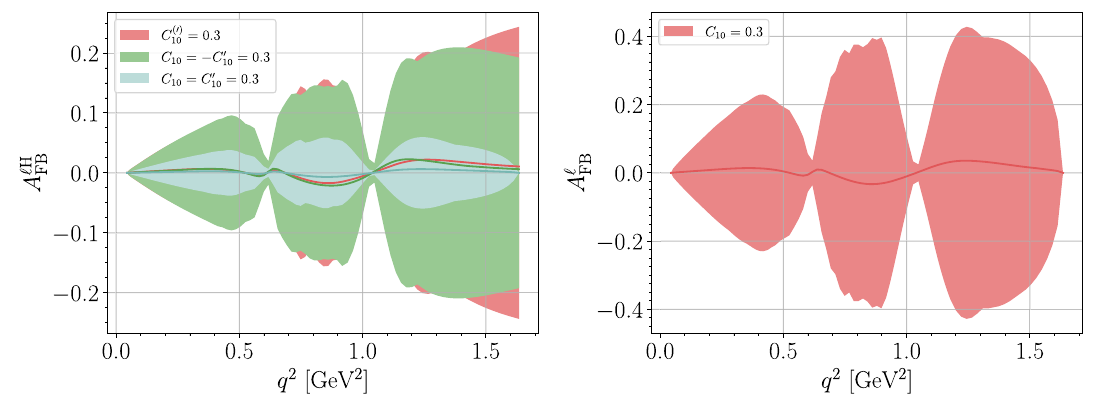
Fig. 2 The left plot shows the forward–backward asymmetry in both (11) only in a C 10 = 0 . 3 scenario. The width The right plot shows A (cid:5) FB hadronic and leptonic scattering angles, A (cid:5) H of the bands stem predominantly from unknown strong phases. Both (16) for (cid:2) + c → (cid:3) + ( → FB = 0 . 3, C = A (cid:5) H and A (cid:5) are null tests of the SM, Eq. p π 0 )μ + μ − decays in NP scenarios with C 10 or C (cid:3) 10 FB FB 10 − C (cid:3) = 0 . 3 and C = C (cid:3) = 0 . 3 in red, green and blue, respectively. 10 10 10